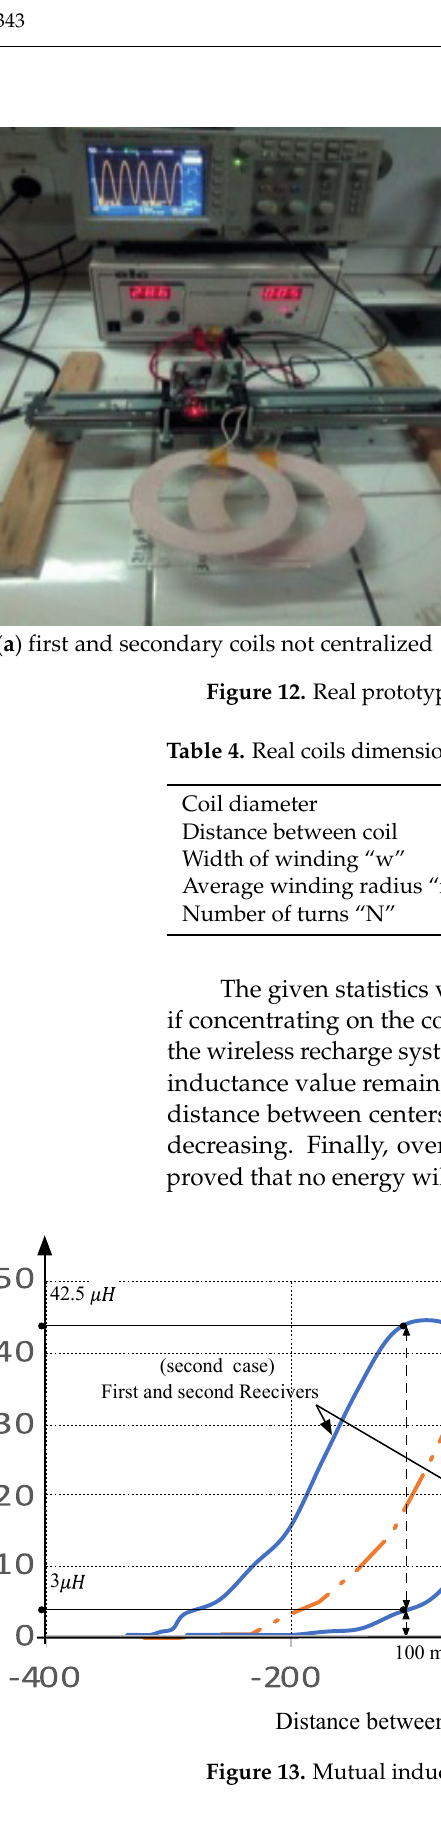
Figure 13. Mutual inductance with one and two receivers.